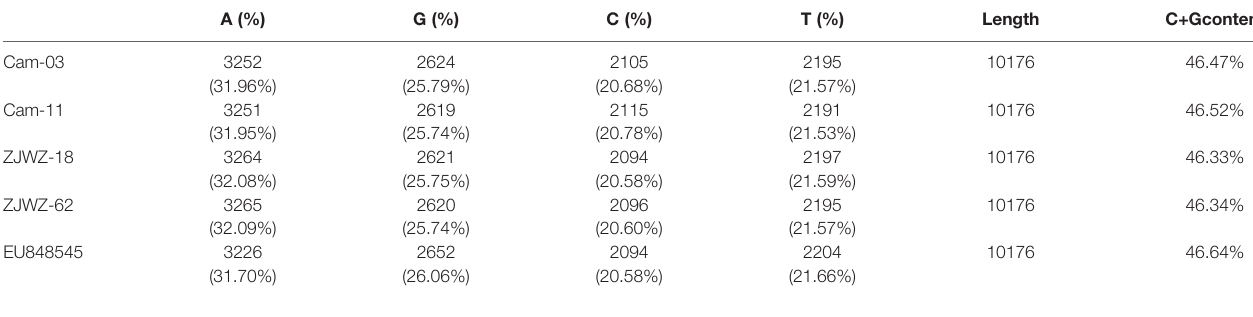
TABLE 1 | Statistical analysis of nucleotides in the coding region of the whole genome